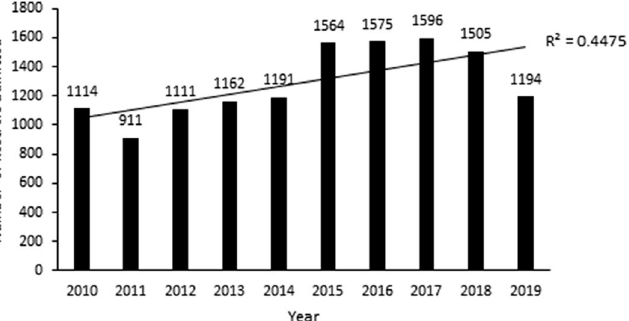
Figure 1. Number of common kestrels admitted to rehabilitation centres in the Czech Republic in the period from 2010 to